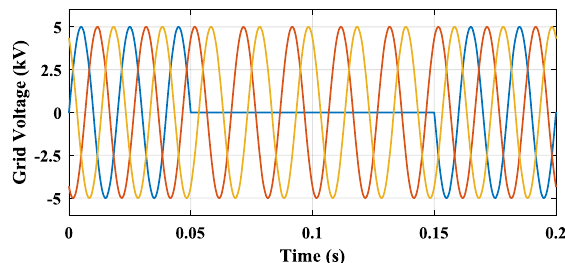
Table 1 MMCC power system parameters